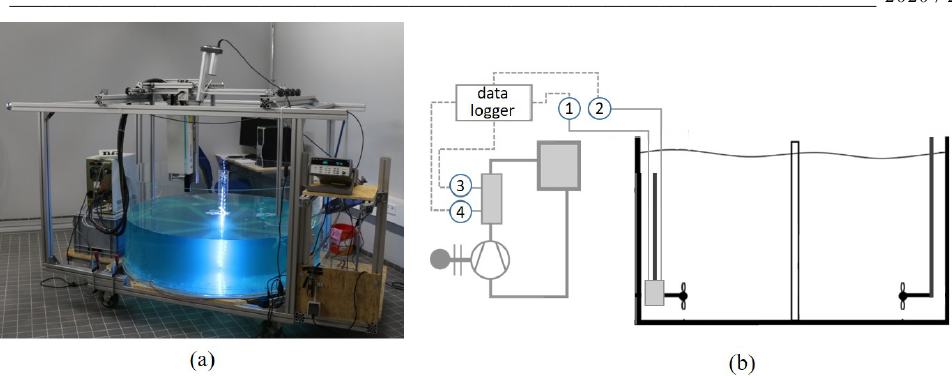
Fig. 3. Mixing system with two horizontal propellers. a) Photo of the laboratory scaled facility, where the tank has a diameter of 1.5 m; b) Scheme of the hydraulic cycle with electrical power supply: Numbers indicate sensors for (1) torque, (2) thrust, (3) pressure, and (4)